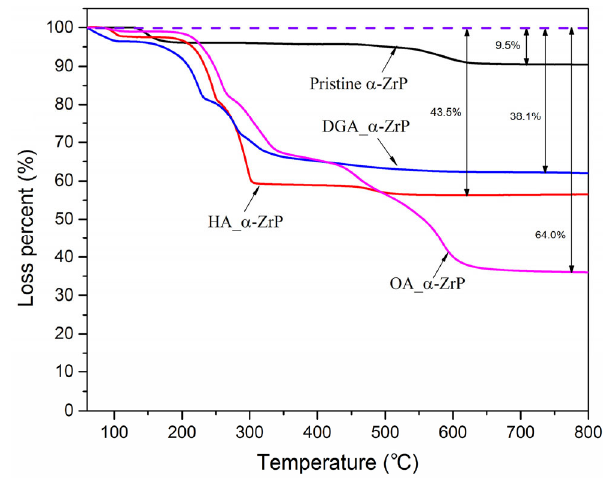
Fig. 4 TGA curves of pristine and amine-intercalated  -ZrP